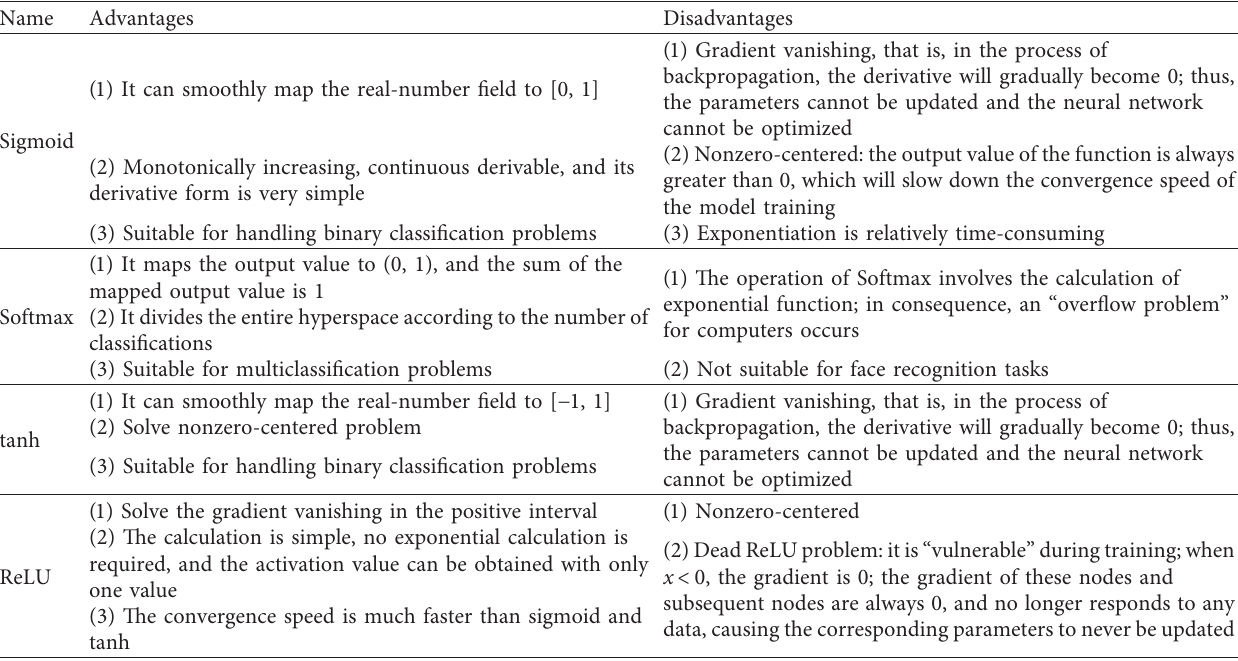
Table 4: Advantages and disadvantages of activation